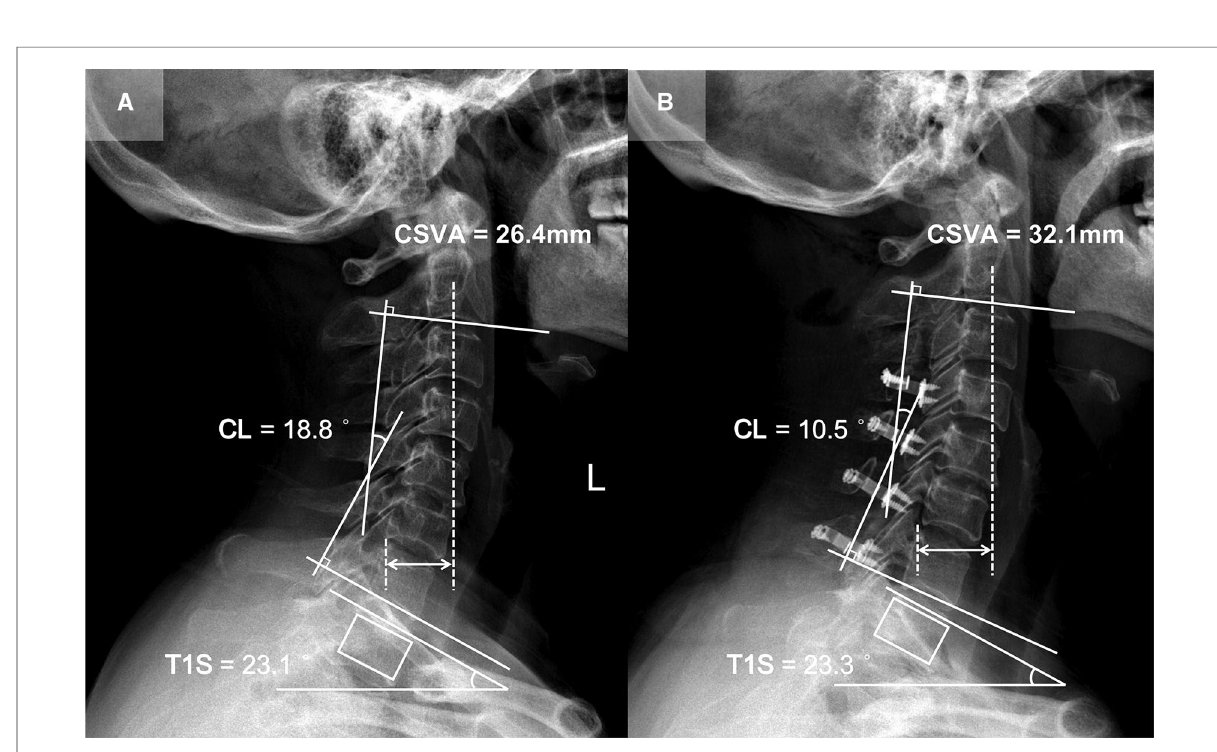
FIGURE 4 Patient case of the CL loss group, T1S decreased subgroup. ( A ) Preoperative lateral cervical radiograph (CL=7.1°, T1S=26.5°, CSVA=34.8 mm). ( B ) Lateral cervical radiograph at fi nal follow-up (15 months after surgery, CL=2.3°, T1S=21.4°, CSVA=32.8 mm).